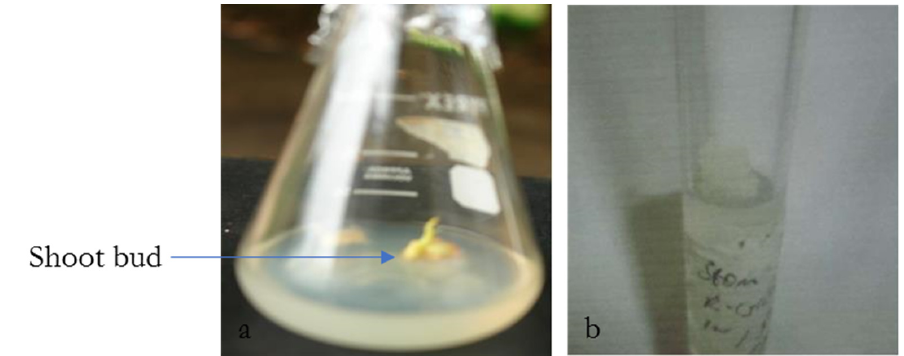
Figure 3. Scanty (with shoot bud) and compact callus induced from cotyledon and stem explant of E. cyclocarpum after three weeks of culture respectively on MS medium supplemented with 4.5 μM 2, 4-D +